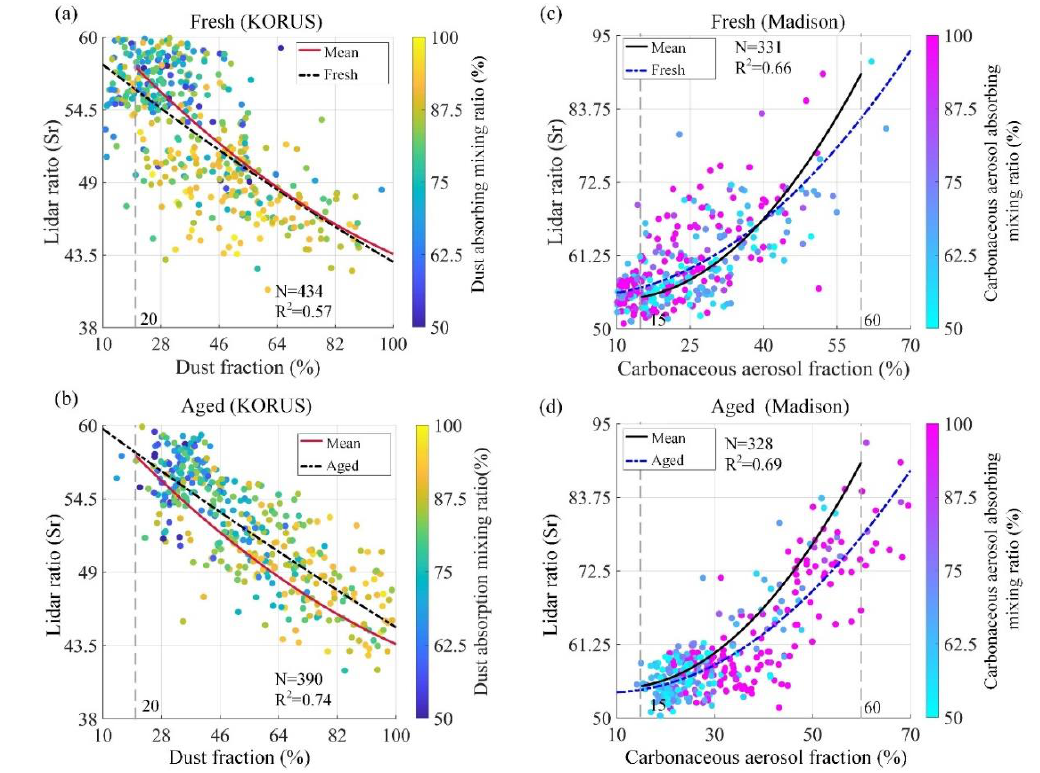
Figure 11. The influence of different types of carbonaceous aerosols (different AAEs and SSAs) on the fitting results of the LR-AFNR model. ( a , b ) represent the results of the fitting curves for different types of carbonaceous aerosols (fresh and aged) under dust-dominated conditions compared with the original fitting curve in Figure 5b. The solid red line represents the original fitting curve, and the black dotted lines represent the fitting curves of fresh and aged smoke; ( c , d ) represent the results of the fitting curves for different types of carbonaceous aerosols (fresh and aged) under carbonaceous aerosol-dominated conditions compared with the original fitting curve in Figure 5f. The solid black line represents the original fitting curve, and the blue dotted lines represent the fitting curves of fresh and aged smoke. N and R 2 represent the number of fitting points and the coefficient of determination, respectively. It should be noted that the solid red line corresponds to the dust fraction range of 20 – 100% in Figure 5b, and the solid black line corresponds to the carbonaceous aerosol fraction range of 15 – 60% in Figure 5f, so only part of the curve is shown in this Figure.